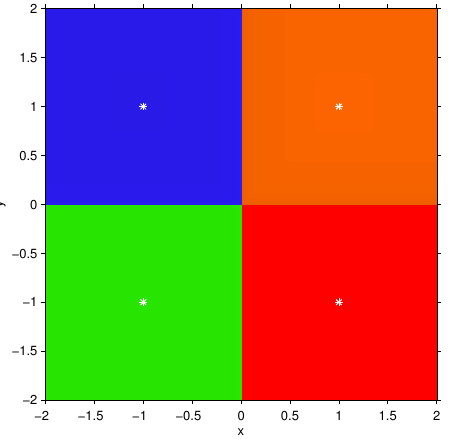
Figure 2. Dynamical plane of CMN m , RMN m and Newton’s method on q ( x ) . Green, orange, red and blue areas are the basins of attraction of the roots of q ( x ) (marked as white